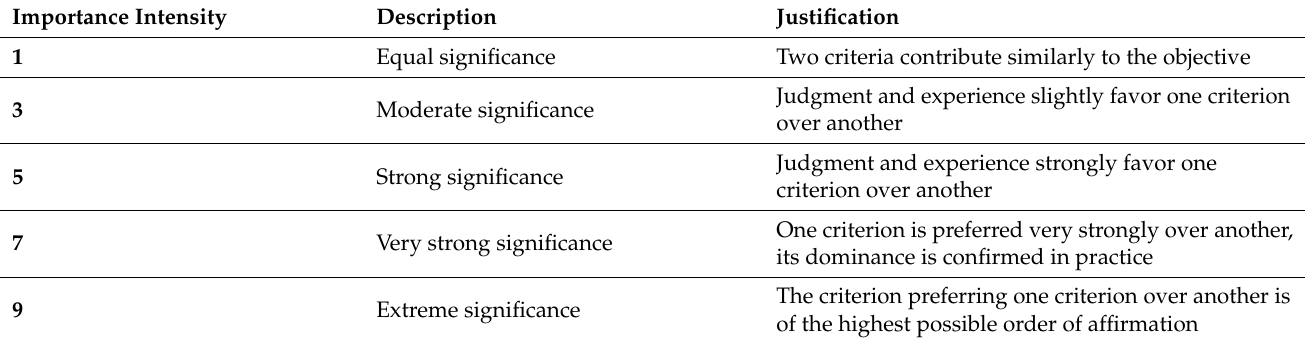
Table 2. Scale of